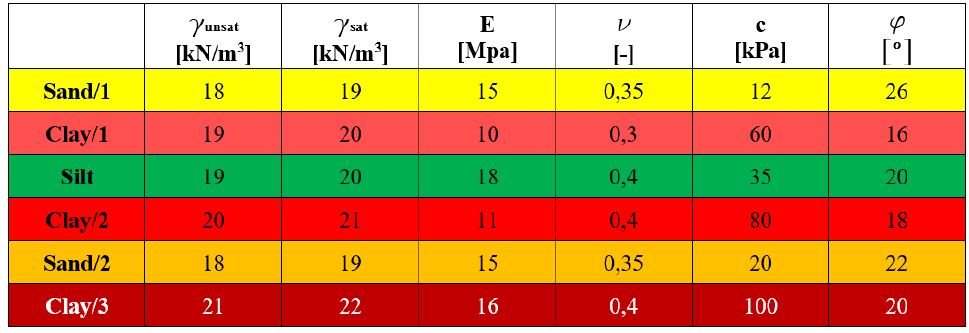
Figure 6. Soil parameters applied in the models.